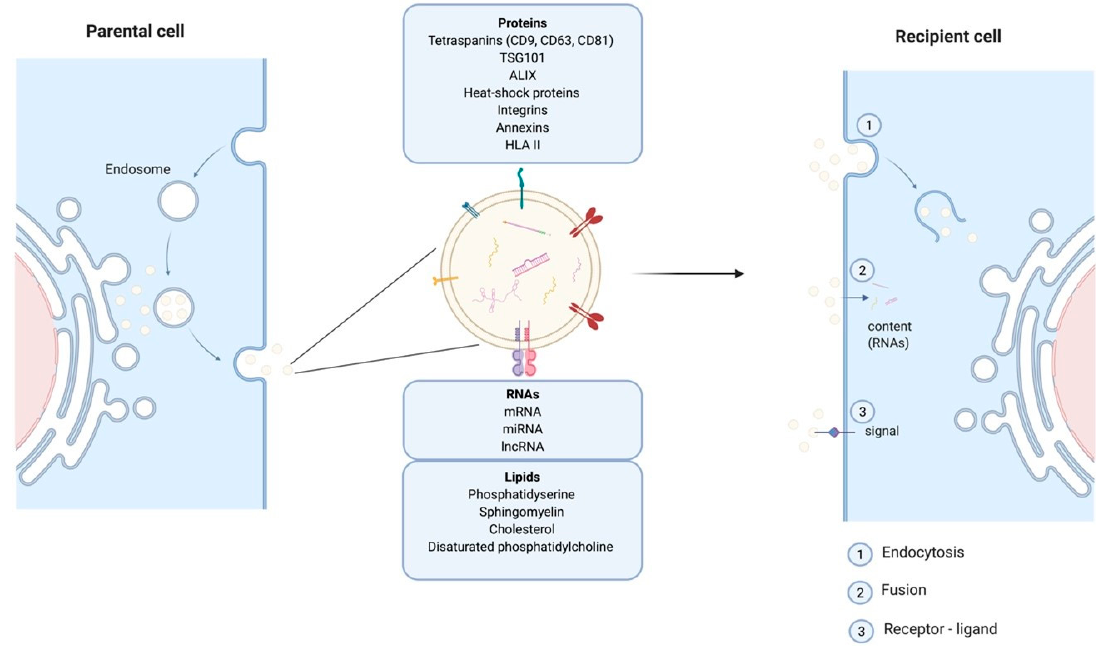
Figure 1. Schematic representation of exosomes endosomal budding detailing their different components and mode of action on recipient cells.